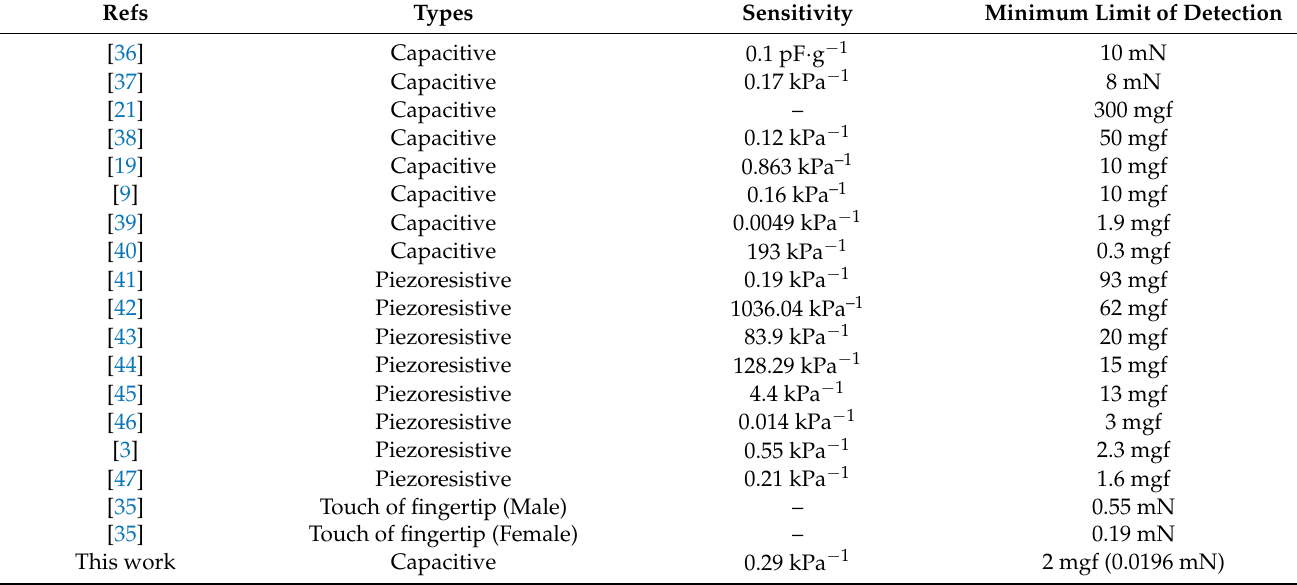
Table 2. Comparison of performance of the No.1 sensor with the other sensors from current references.